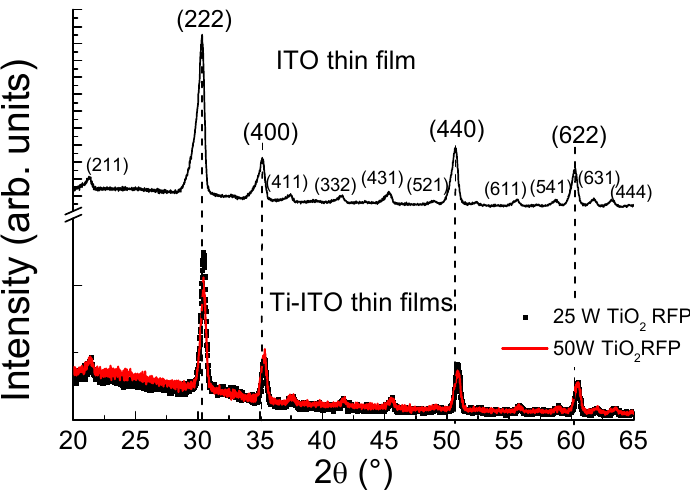
Figure 8. XRD pattern of the films in study. Table 8. FOM and average T NIR values capability as function of the sputtering conditions used. The In 2 O 3 concentration, the amount of In-saving and the resistivity of the films are also included. ITO DCP (W)